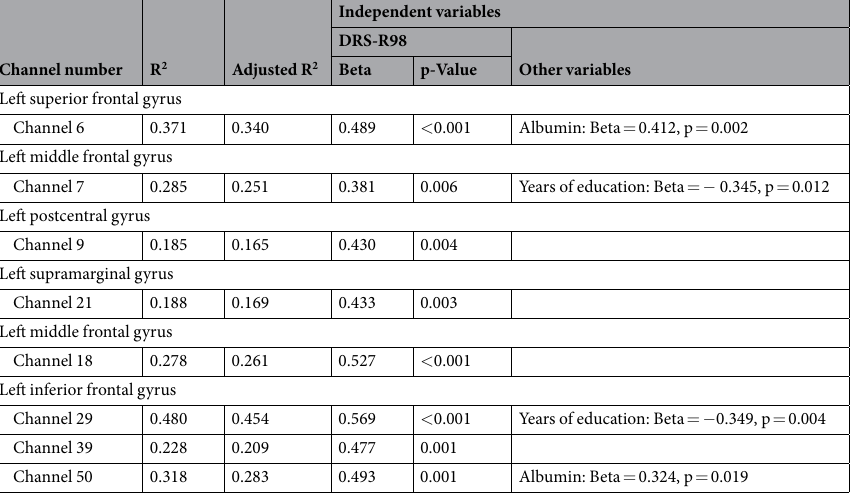
Table 2. Multiple regression analysis based on DRS-R98 and demographic variables. Regression analyses were conducted after false discovery rate corrections were made at each channel. DRS-R98, age, gender, years of education, antidepressants, model for end-stage liver disease (MELD) score, Charlson comorbidity index, serum hemoglobin concentration, serum albumin concentration, international normalized ratio (INR) and task performance were independent variables entered in the